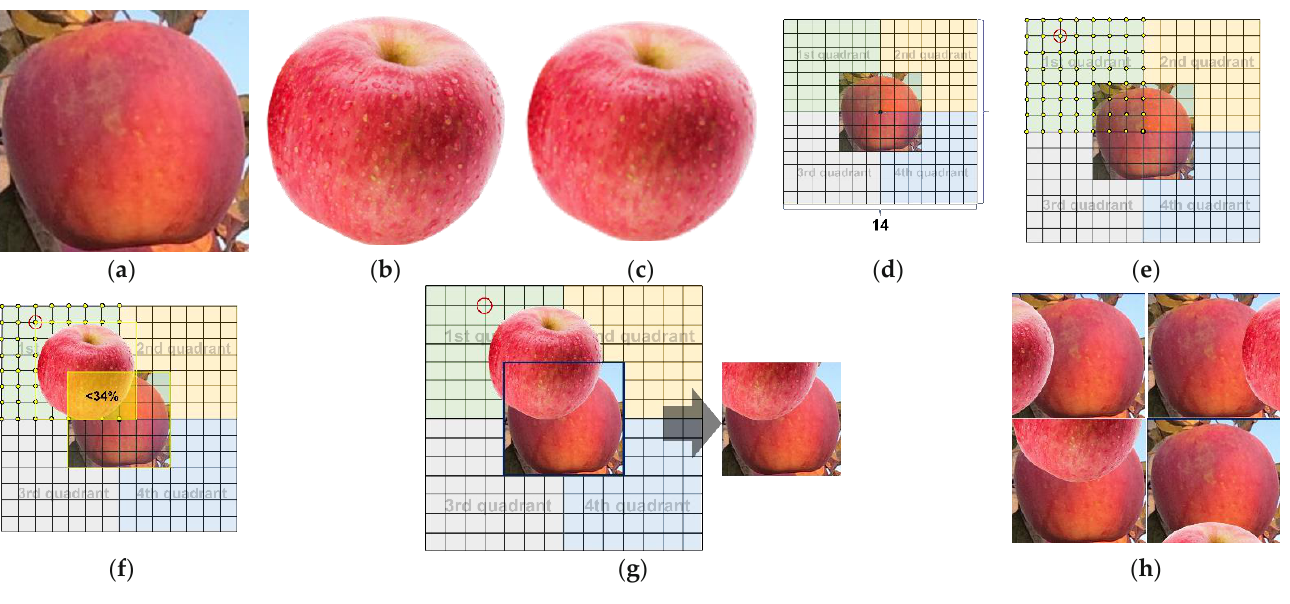
Figure 7. The synthesis process of F: ( a ) N is selected from annotated images. ( b ) Fruit occlusion element is selected from the component pool. ( c ) Fruit occlusion element is resized to N size. ( d ) N is divided into 6 × 6 grid regions, a 14 × 14 grid region is created with the center of N as the origin, and it is divided into four quadrants. ( e ) The randomly selected start point of the fruit occlusion element is based on the first quadrant, which is a red circle. ( f ) The fruit occlusion element is attached to the 14 × 14 grid area based on the random starting point, ensuring that the overlap between the fruit occlusion element and N is less than 34% of N area. ( g ) The original image is cut in according to the size of N to form F. ( h ) The other four F.